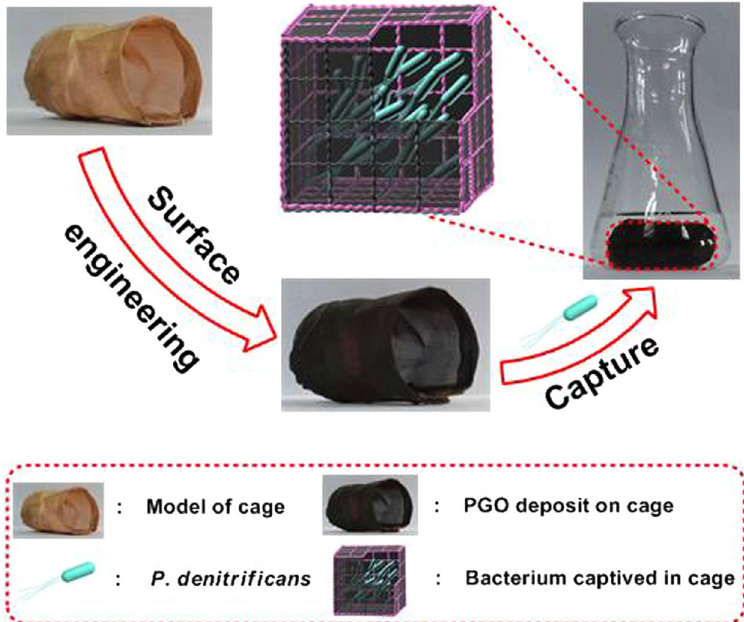
Figure 2. Schematic illustration of P . denitrificans captived into the cage of CM@PGO.